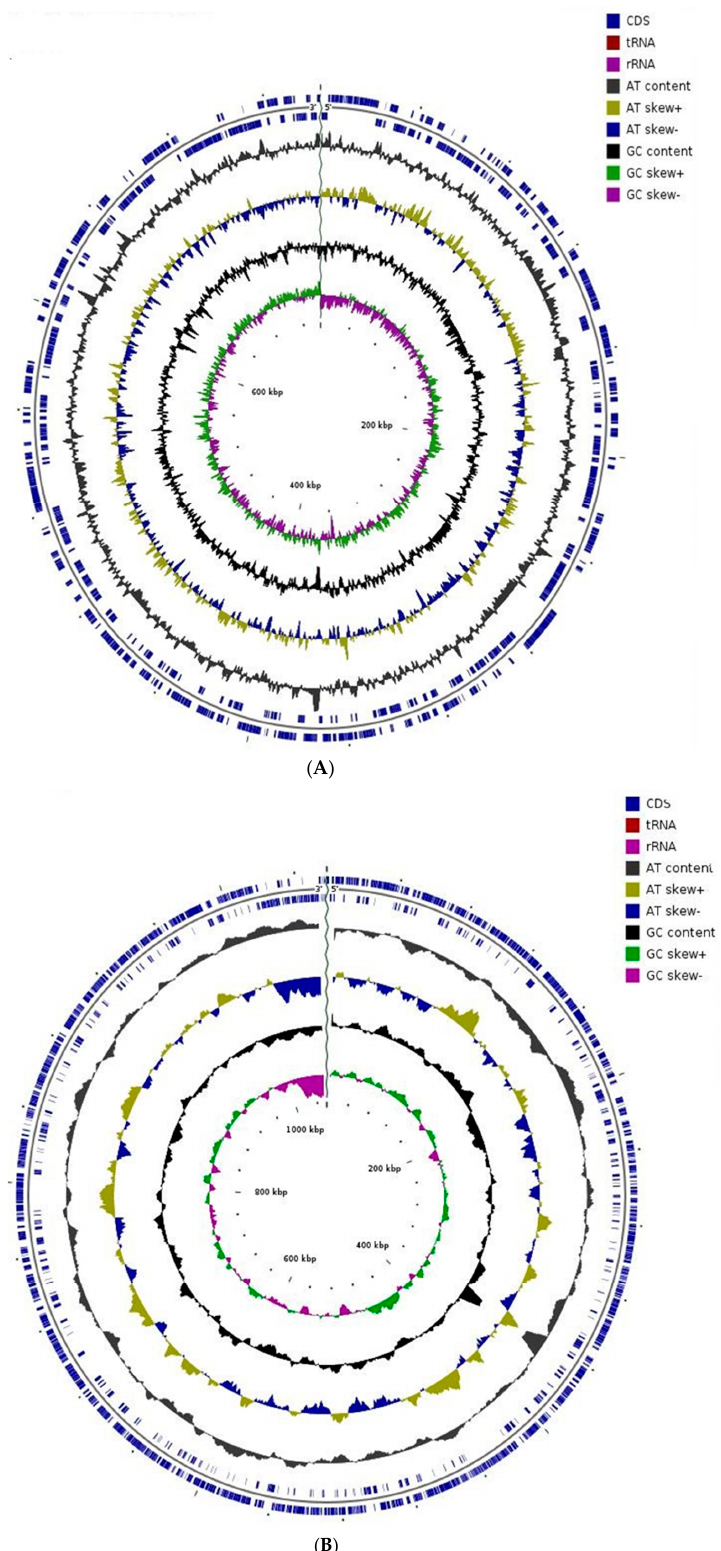
Figure 3. ( A ) Circular overview of the genome of endophytic Pseudomonas carnis strain NWUBe30. ( B ) Circular overview of the genome of endophytic Stenotrophomonas geniculata strain NWUBe21. Table 3. Biosynthetic gene clusters of two endophytic bacterial strains, as predicted by antismash.